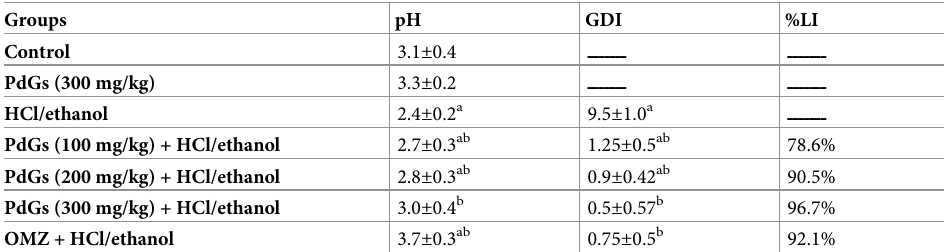
Values were expressed as the mean ± SD of 7 rats. a p < 0.05, significant change with respect to Control rats b p < 0.05, significant change with respect to HCl/ethanol-induced gastric